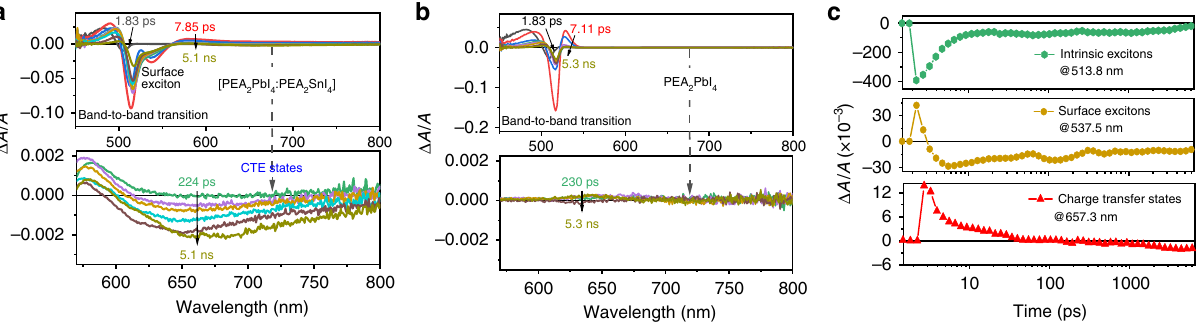
Fig. 4 Transient absorption (TA) characteristics for 2D perovskite heterostructures and PEA 2 PbI 4 . a TA spectra for 2D perovskite heterostructured [(PEA 2 PbI 4 ) 0.95 :(PEA 2 SnI 4 ) 0.05 ] fi lm. b TA spectra for pristine PEA 2 PbI 4 fi lm. c TA dynamics plotted for band-to-band transition (513.8 nm), surface excitons (537.5 nm), and broad emission (657.3 nm) in 2D